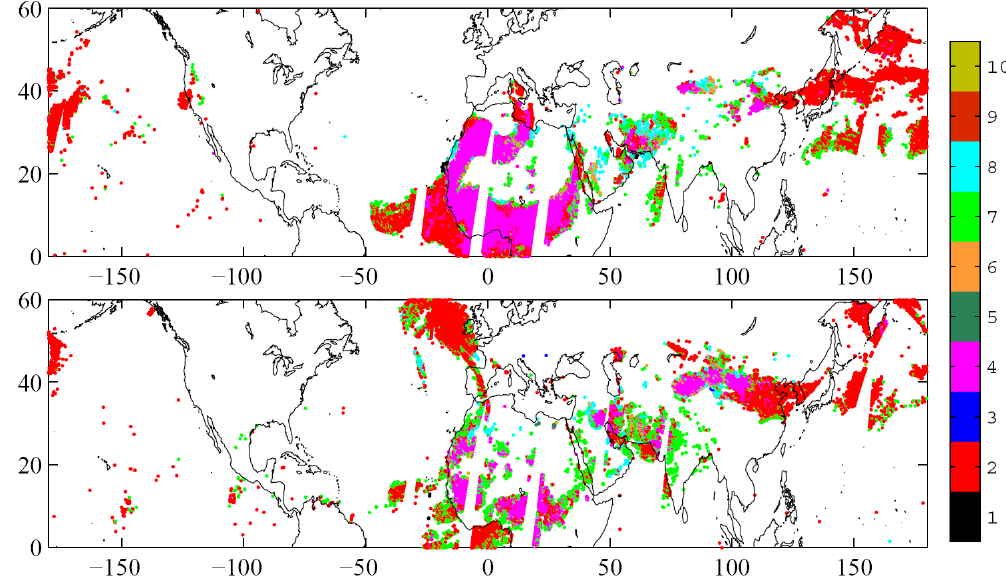
Fig. 5. Sand aerosols detected over the Northern Hemisphere on 23 March 2010 (top) and 8 April 2011 (bottom) based on strict thresholds for R N and A N for each of the ten tests. The colorcode corresponds to the test which passed (see Fig. 4). In case multiple tests flagged an observation, only the lowest test number is